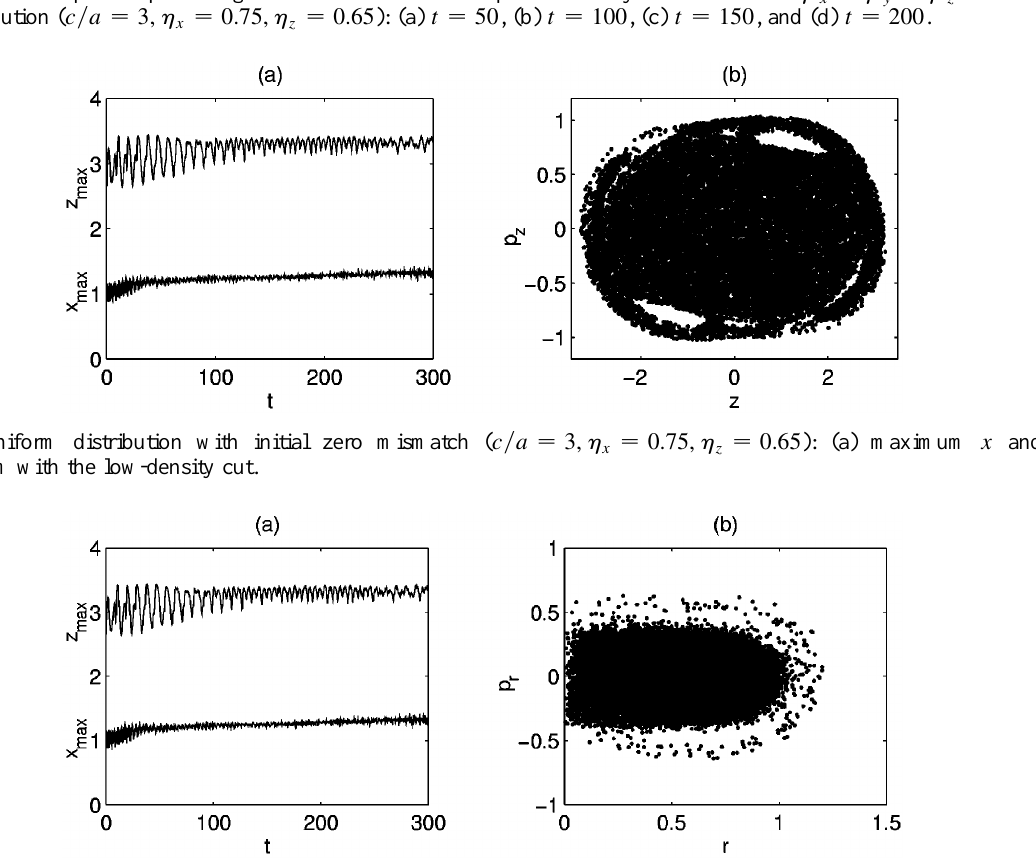
FIG. 7. 6D uniform distribution with initial zero mismatch ( (cid:99) (cid:121) (cid:97) (cid:173) (cid:51)(cid:44) h (cid:120) (cid:173) (cid:48)(cid:46)(cid:51)(cid:56)(cid:44) h (cid:122) (cid:173) (cid:48)(cid:46)(cid:50)(cid:55) ): (a) maximum (cid:120) and (cid:122) and (b) (cid:114) (cid:45) (cid:112) (cid:114) diagram at (cid:116) (cid:173) (cid:51)(cid:48)(cid:48) (with 25 000 particles